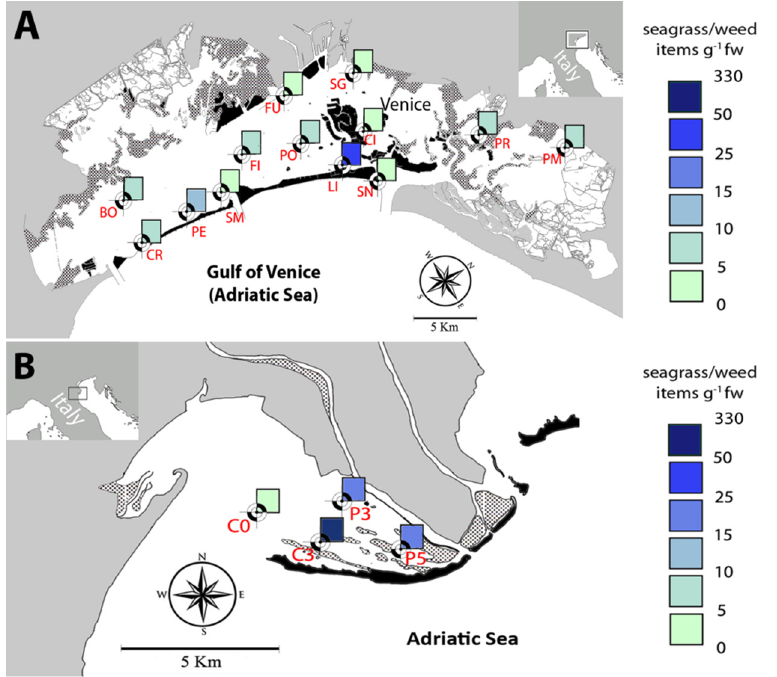
Figure 4. Postmap of the average microplastic contamination in macroalgae from the Venice Lagoon ( A ) and the Goro Lagoon ( B ) .